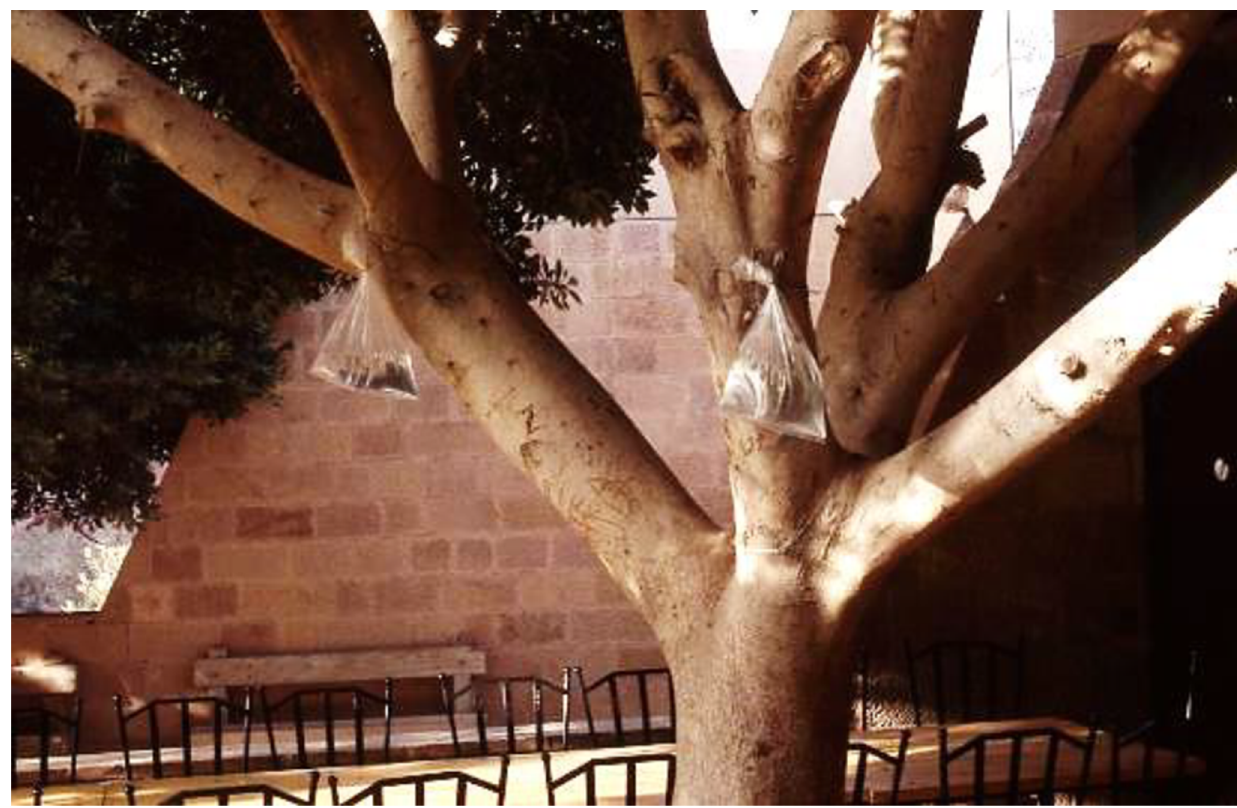
Figure 5. Bags of water for fly management hanging from a Ficus tree at an outdoor restaurant in Petra, Jordan, 1997.